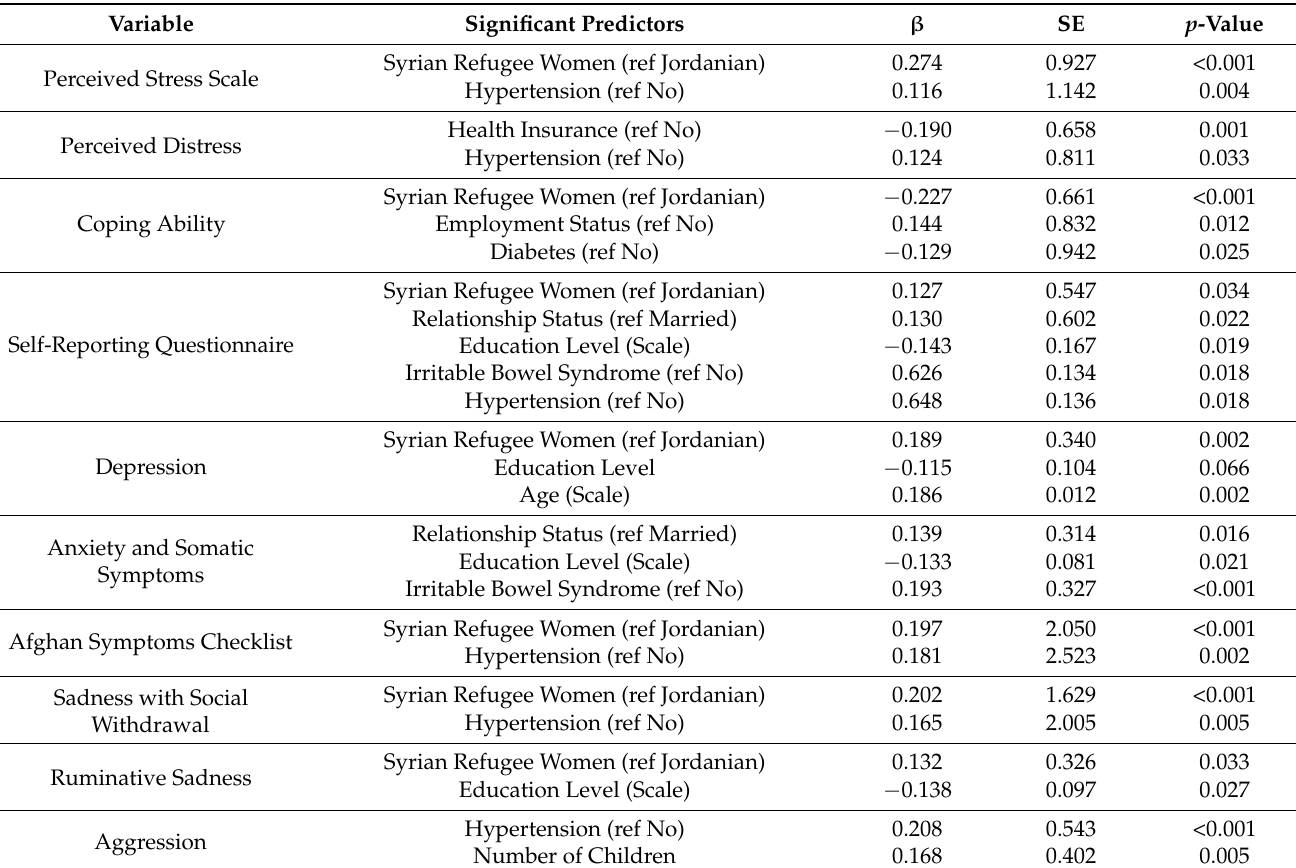
Table 2. Linear regression analyses for perceived stress and mental health measures and participants’ sociodemographic